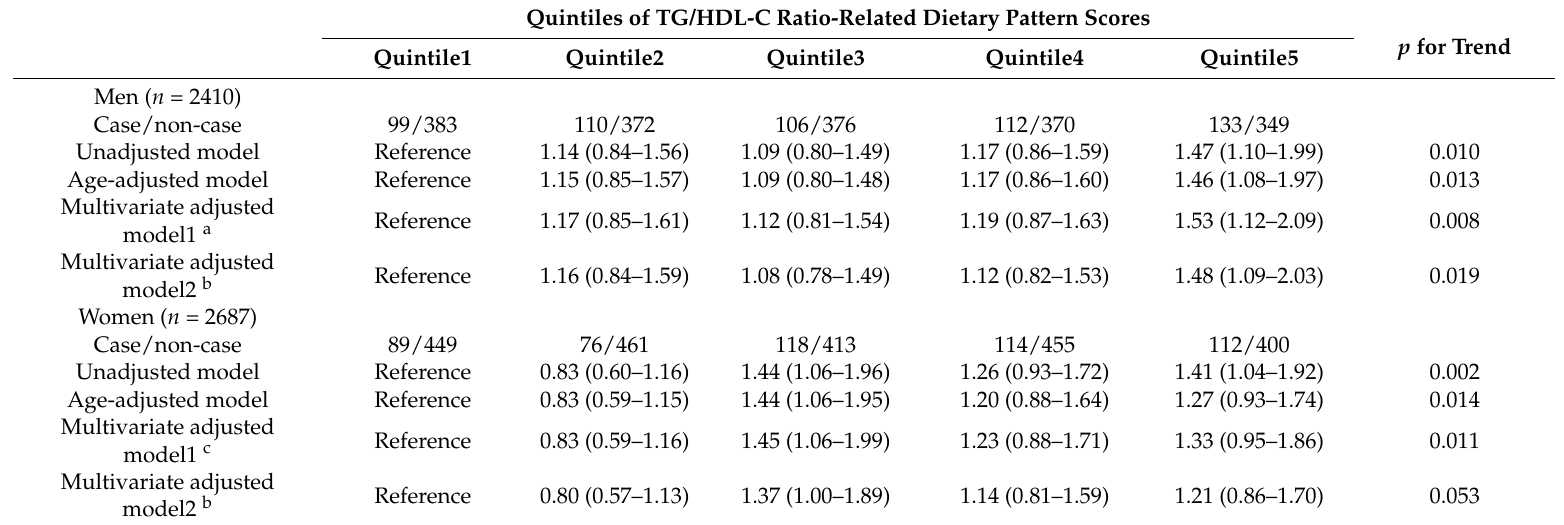
Table 3. Odds ratios (ORs) and 95% confidence intervals (CIs) of incident type 2 diabetes according to the quintiles of TG/HDL-C ratio-related dietary pattern scores. Quintiles of TG/HDL-C Ratio-Related Dietary Pattern